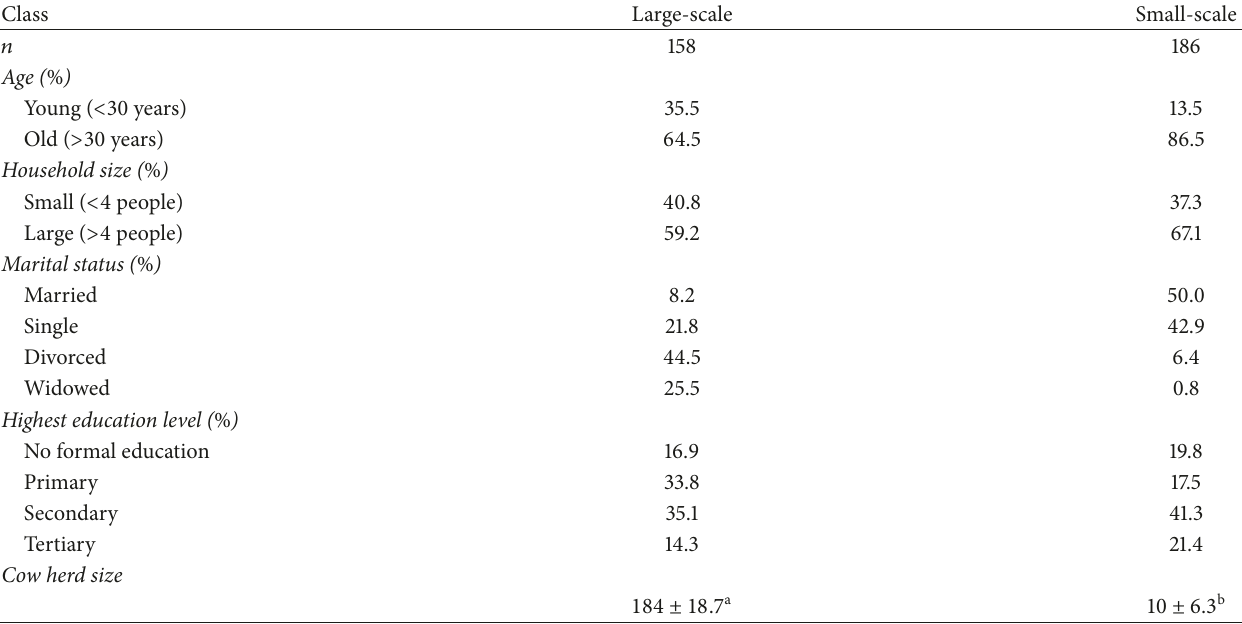
Table 1: Sociodemographic characteristics, mean herd size ( ± SD), and the number of respondents from each production